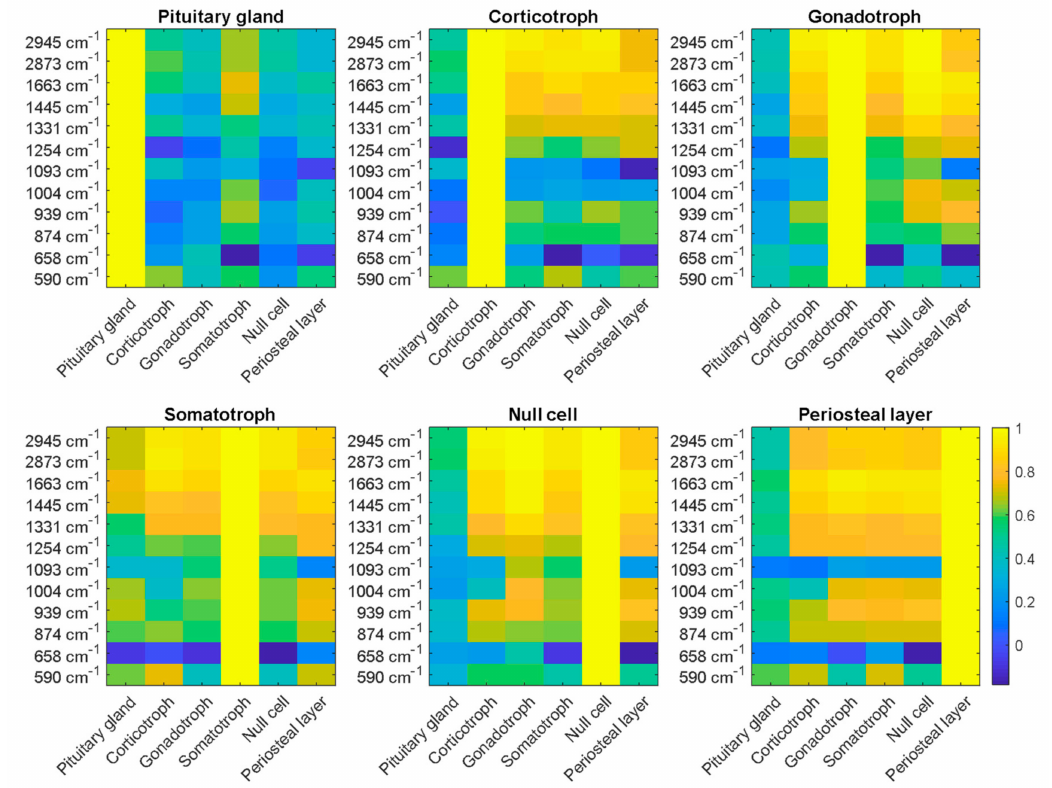
Figure 7. Correlation coe ffi cients were calculated between LSRM images of pituitary gland, periosteal layer and adenoma subtypes (corticotroph, gonadotroph, somatotroph and null cell) at representative wavenumbers. The significance of these peaks was determined via the results of the PCA. Pituitary gland could be clearly discriminated based on the correlation coe ffi cients between the di ff erent classes. As indicated on the color bar on the right, the correlation coe ffi cient ranges from 0 to 1, where 1 quantifies high correlation between the investigated